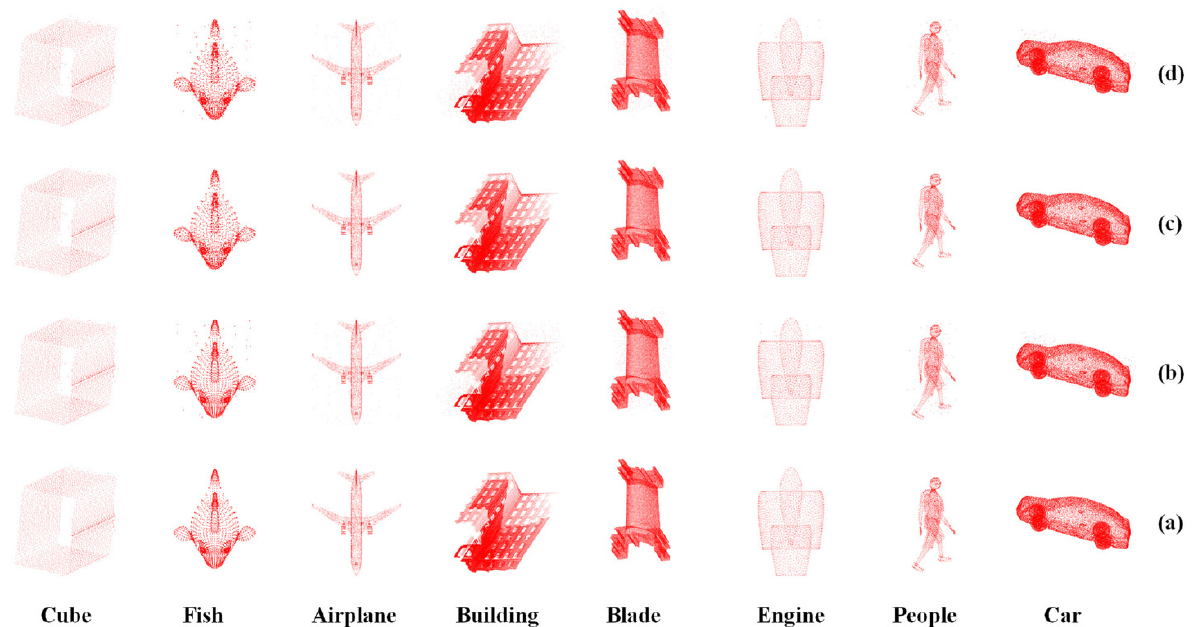
Figure 2. The point cloud models used in this work. ( a ) are the original point cloud models; ( b ) are the point cloud models after adding large-scale noise; ( c ) are the point cloud models after adding small-scale noise; ( d ) are the point cloud models after adding multi-scale noise.